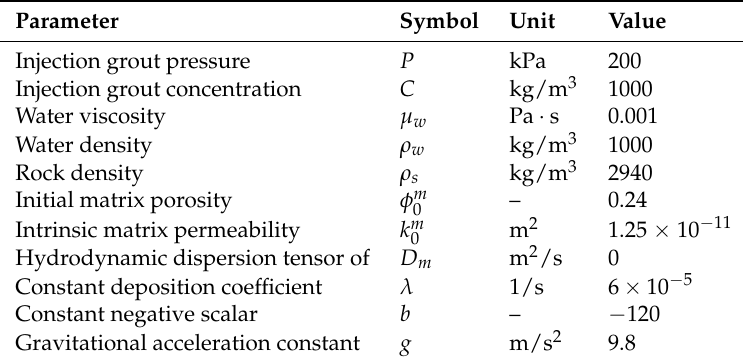
Table 2. Parameters for the sensitivity